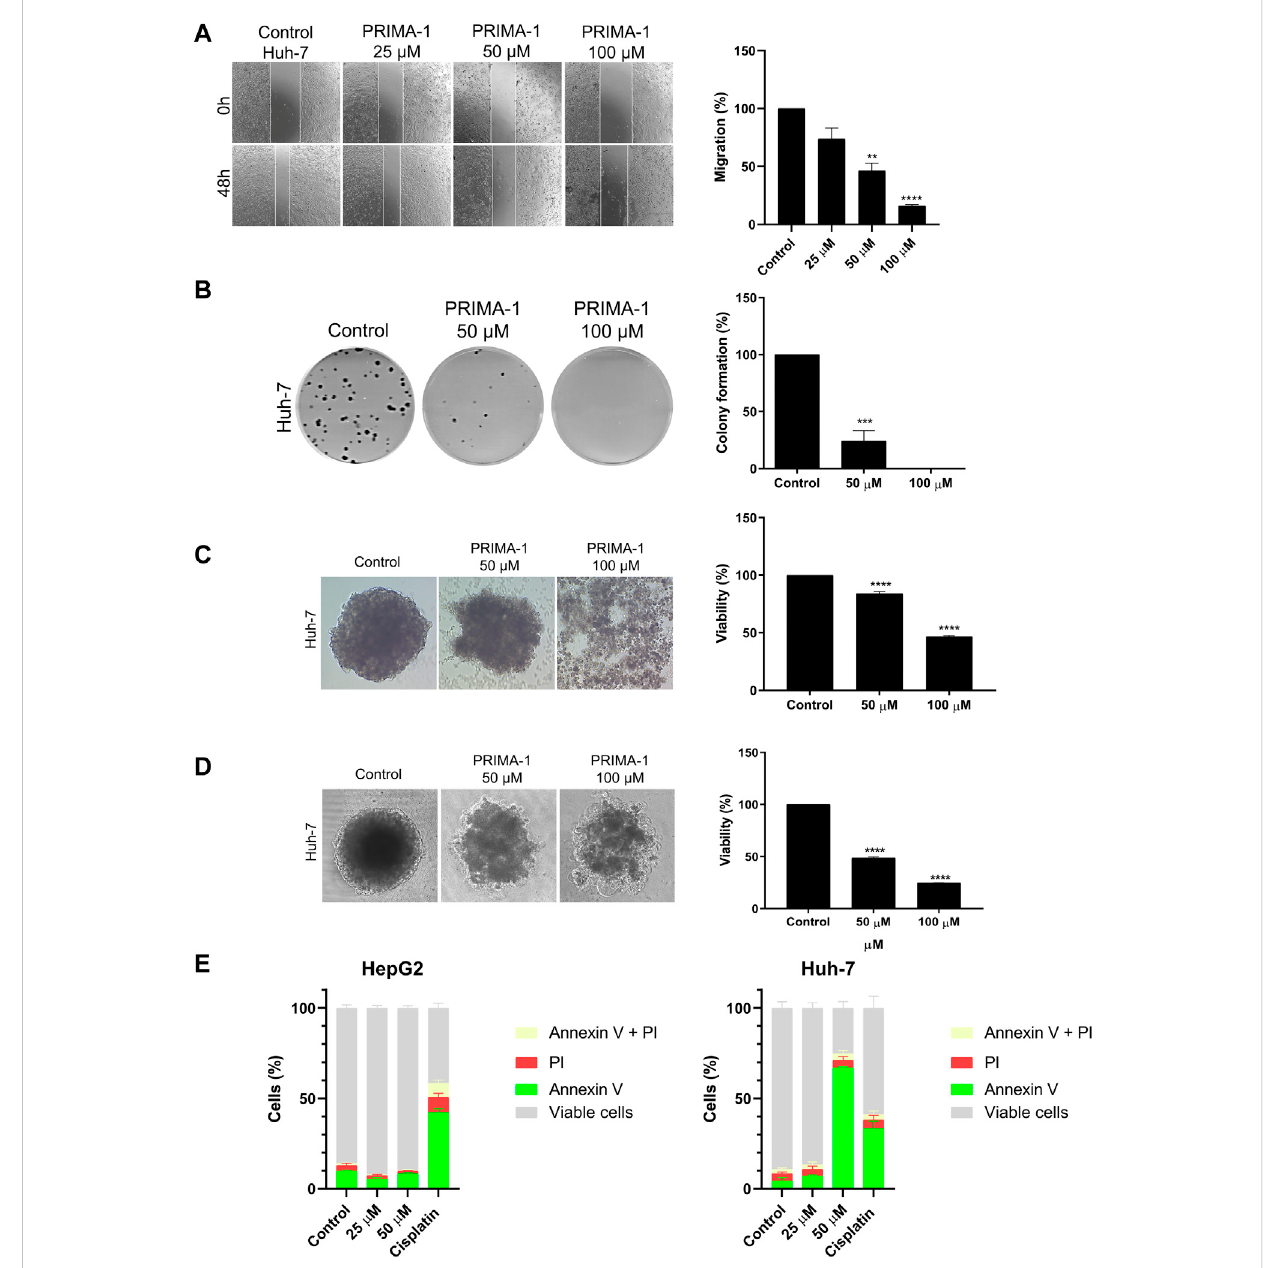
FIGURE 7 PRIMA-1 reduces GoF-related effects in HCC cells. (A) Migration of HepG2 and Huh-7 cells treated with PRIMA-1 (25, 50, and 100 µM). Values are expressedasapercentageofcontrolmigration. (B) ClonogenicassayofHuh-7cellstreatedwithPRIMA-1(50and100 µM)andstainedwithcrystalviolet. (C) Huh-7 spheroids simultaneously prepared and treated with PRIMA-1. (D) Previously formed spheroids treated with PRIMA-1 at 50 and 100 µM. (E) Apoptosis detection using annexin V-FITC and propidium iodide (PI), with HepG2 and Huh-7 cells treated with PRIMA-1 (25 and 50 µM). Cisplatin (200 µM) was used as a positive